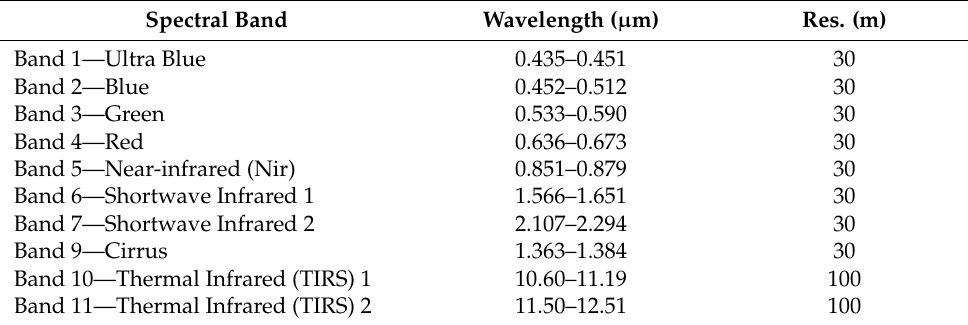
Table 1. The bandwidth and spatial resolution of the SPARCS dataset.